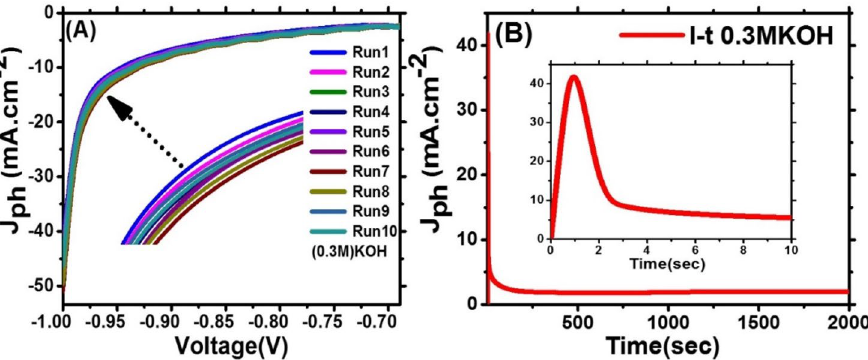
Figure 9. ( A ) J ph –voltage characteristics for different numbers of runs and ( B ) J ph –time characteristic in 0.9 V of PEC HER reaction under white light illumination using 0.3 M KOH and T-LDH/PbI 2